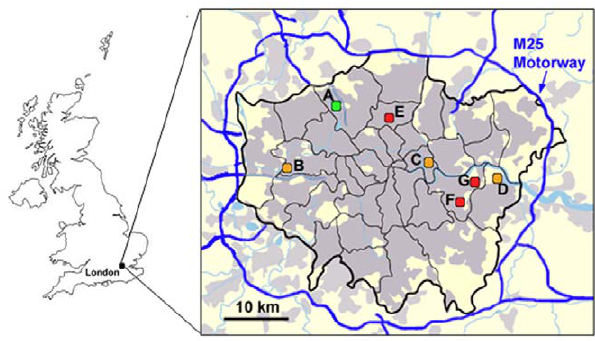
Figure 1. Primary school sampling sites in the Greater London Urban Area. Site A represents the suburban site. The urban background and roadside are indicated by sites B–D and sites E–G, respectively. The M25 motorway encircles the city and drawn in blue while the black lines mark the boroughs of London.